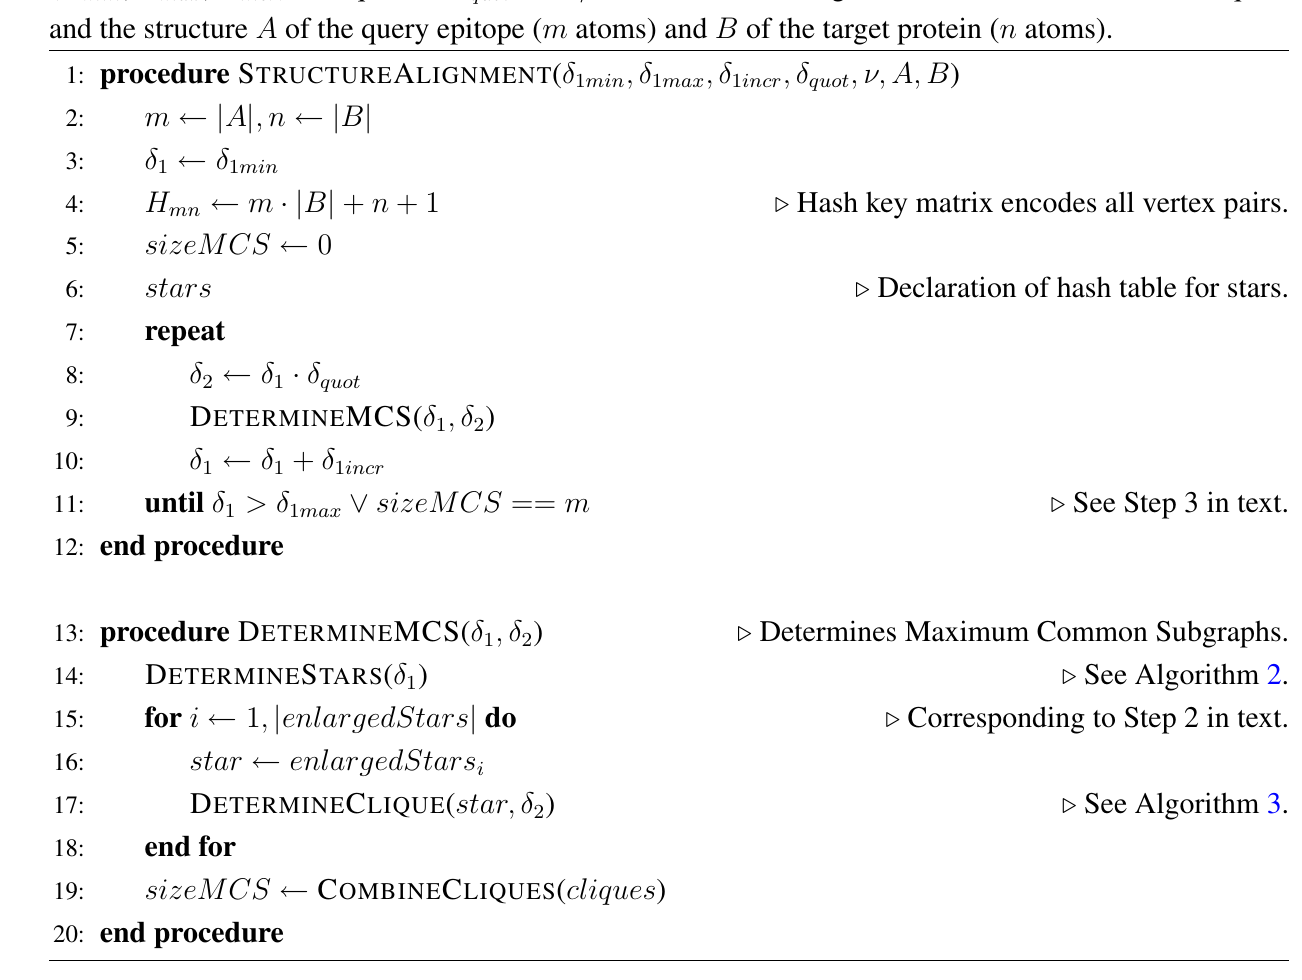
Algorithm 1 The central part of the EpitopeMatch algorithm. Several parameters are